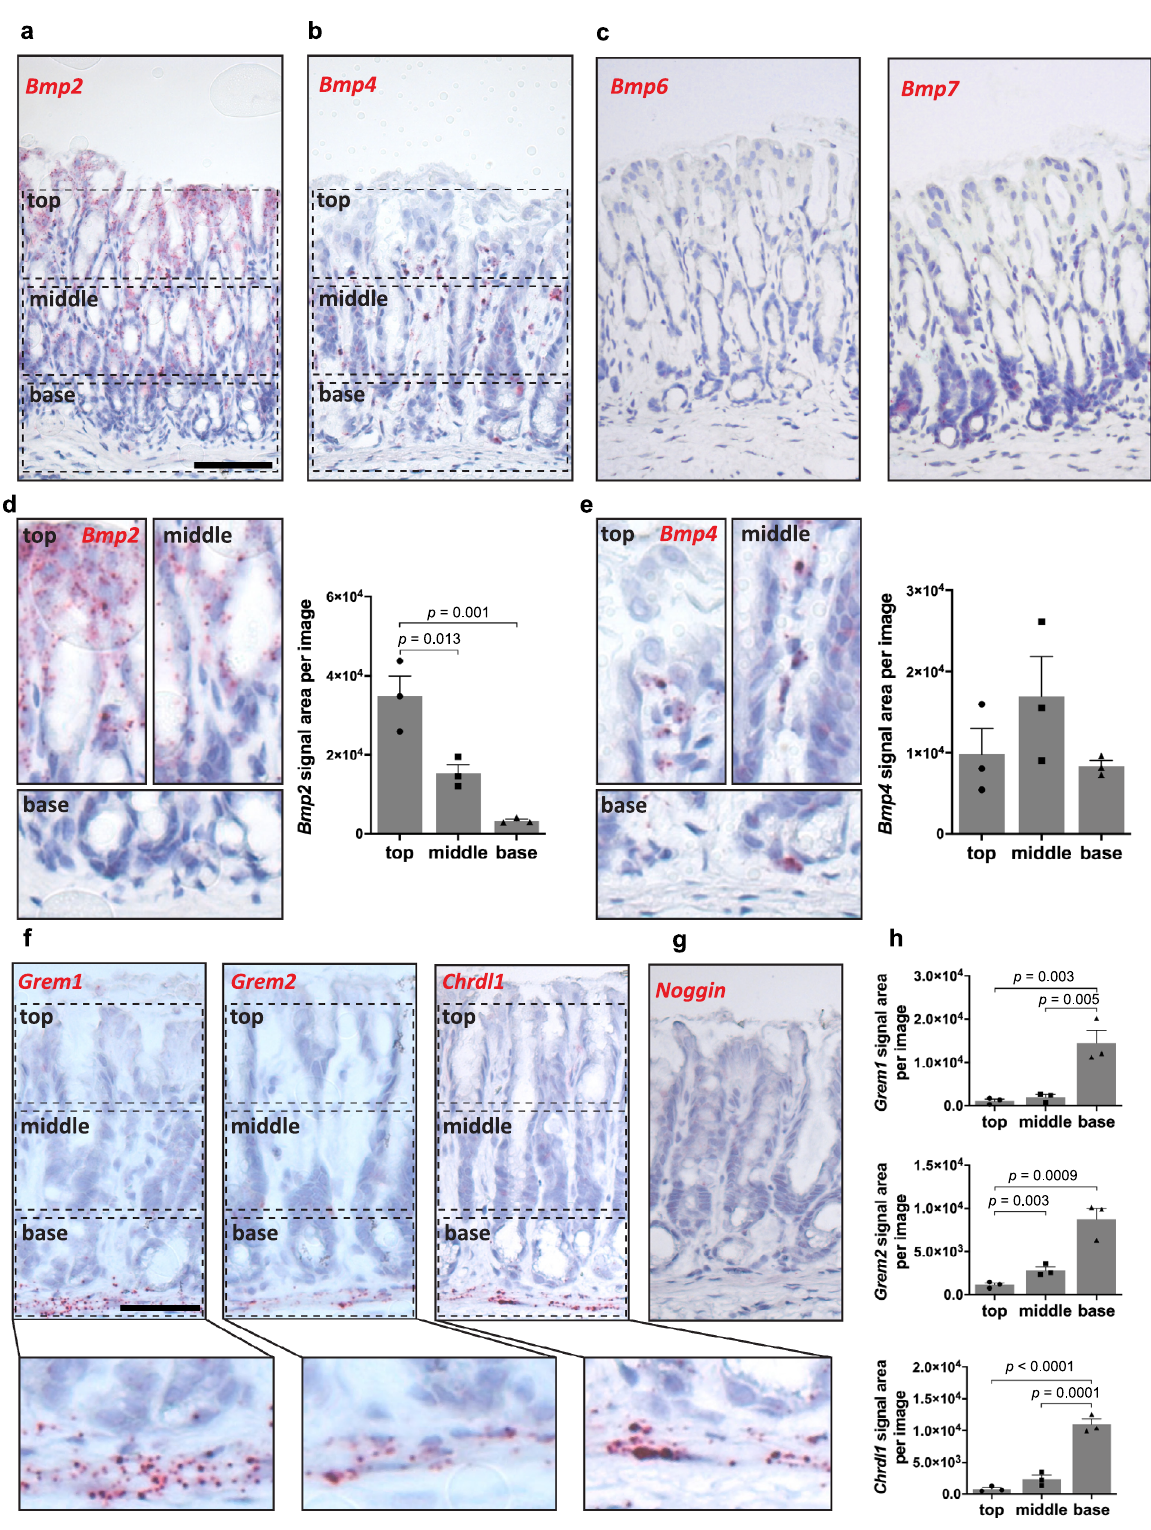
Fig. 2 BMP signaling shows highly organized distribution in gastric glands, with strong expression in the pit cells and absence or inhibition in the gland base. a – c Single-molecule in situ hybridization (sm-ISH) for Bmp2 , Bmp4 , Bmp6 , and Bmp7 in antrum tissue ( n = 3). d , e High magni fi cation and quanti fi cation for Bmp2 and Bmp4 signal area per picture divided into top, middle, and base of the gland ( n = 3). f Sm-ISH for Grem1 , Grem2 , and Chrdl1 in antrum tissue with high magni fi cation of the gland base ( n = 3). g Sm-ISH for Noggin in antrum tissue. h Quanti fi cation for Grem1 , Grem2 , and Chrdl1 signal area per picture divided for top, middle, and base ( n = 3). Images are representative of at least three biological replicates. Scale bar: 100 µ m. Data are presented as mean ± SEM. Statistical analyses were performed using one-way ANOVA, followed by Tukey ’ s multiple comparisons test for ( d , e , h ). Source data are provided as a Source Data fi